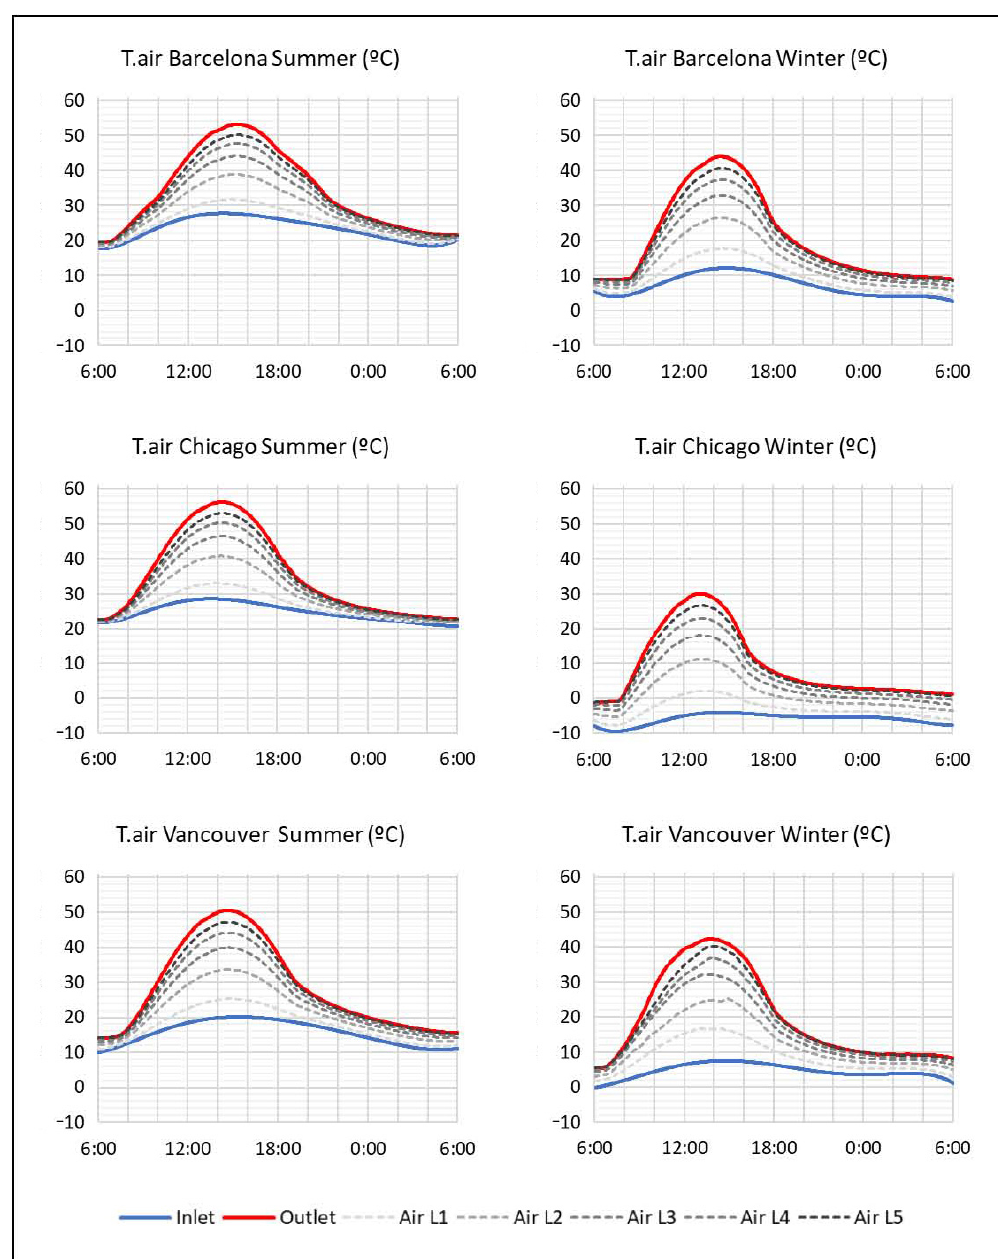
Figure 12. Temperatures of the inlet and outlet air and the air circulating through each louvre (L1 to L5).